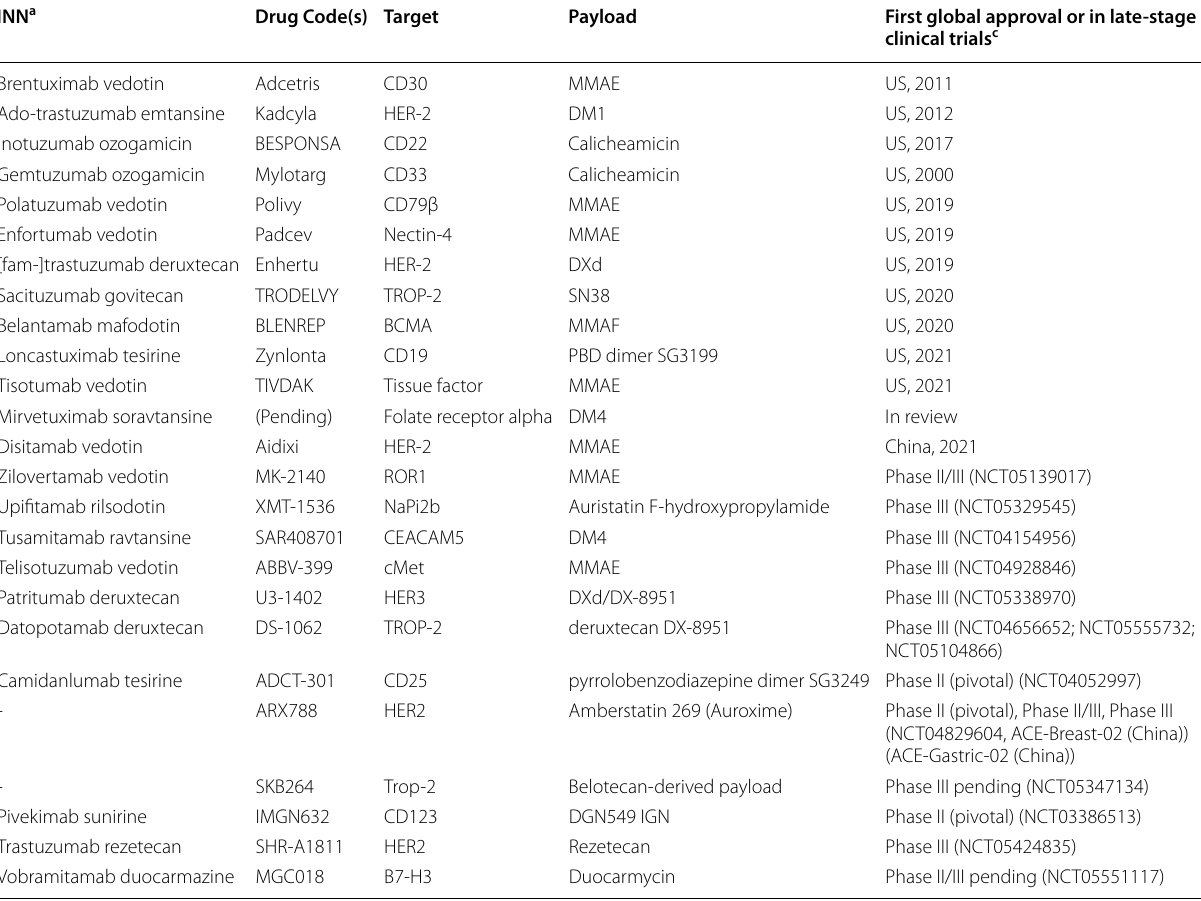
Table 2 ADCs first approved or in late-stage clinical trials in oncology b